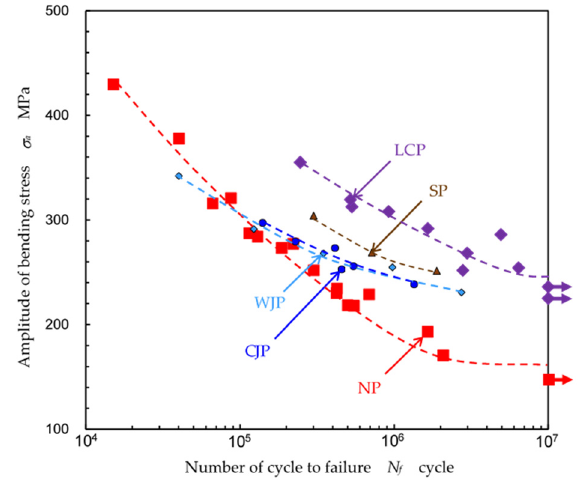
Figure 12. S-N diagram of welded specimens with and without laser cavitation peening compared with other peening methods. NP, non-peened; LCP, laser cavitation peening; SP, shot peening; WJP, water jet peening; CJP, cavitating jet peening (cavitation peening using cavitating jet). The SP, WJP, and CJP data were taken from [10].